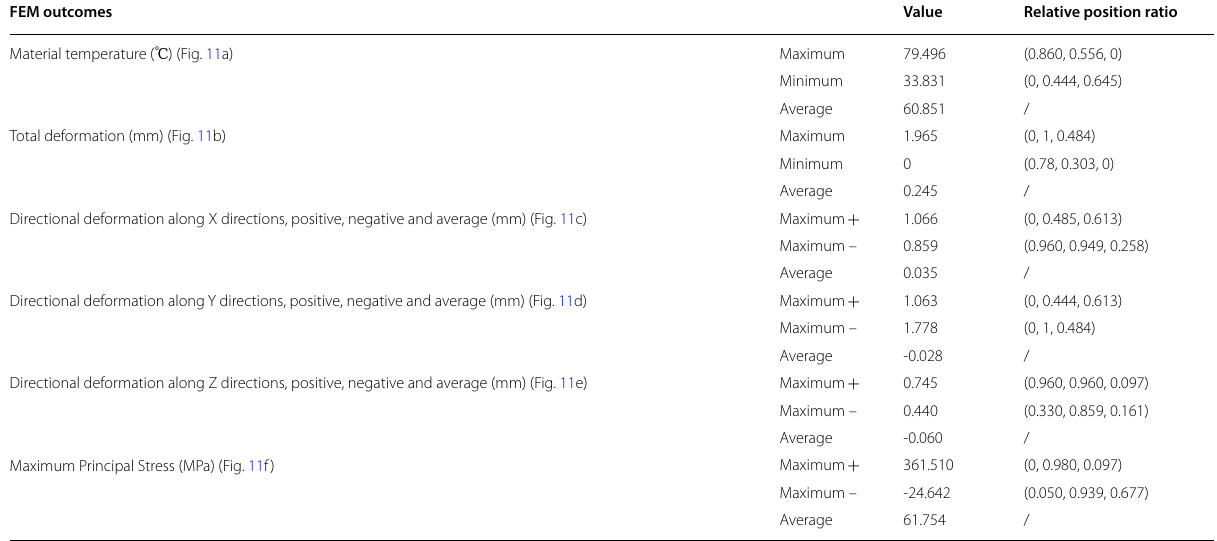
Table 4 Detailed outcomes of FEA FEM